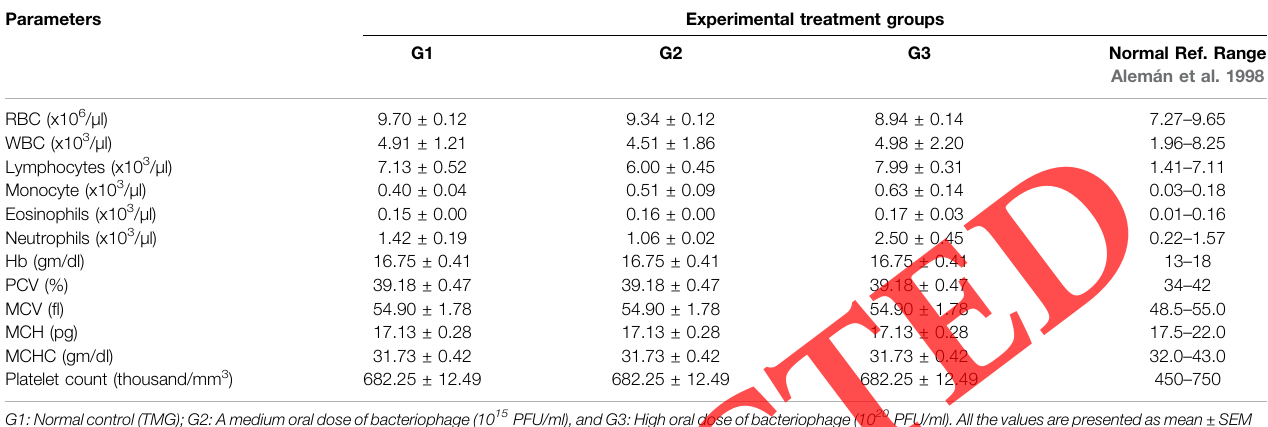
G1:Normalcontrol(TMG);G2:Amediumoraldoseofbacteriophage(10 15 PFU/ml),andG3:Highoraldoseofbacteriophage(10 20 PFU/ml).Allthevaluesarepresentedasmean ± SEM ( n (cid:2) 6). No signi fi cant difference could be found among the different groups ( p > 0.05). The normal reference ranges of hematologicalparameters were mentioned and compared as per animal Clinical Laboratory